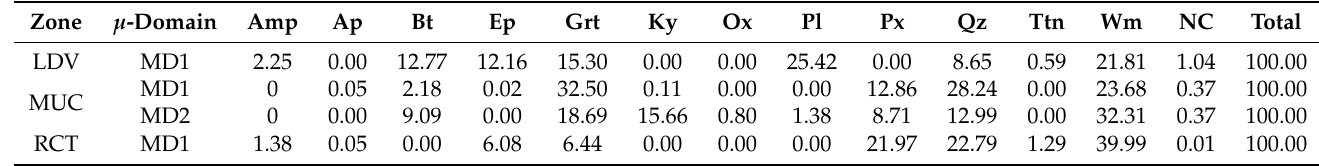
Table 6. Q-XRMA First Cycle—Phases Percentages.